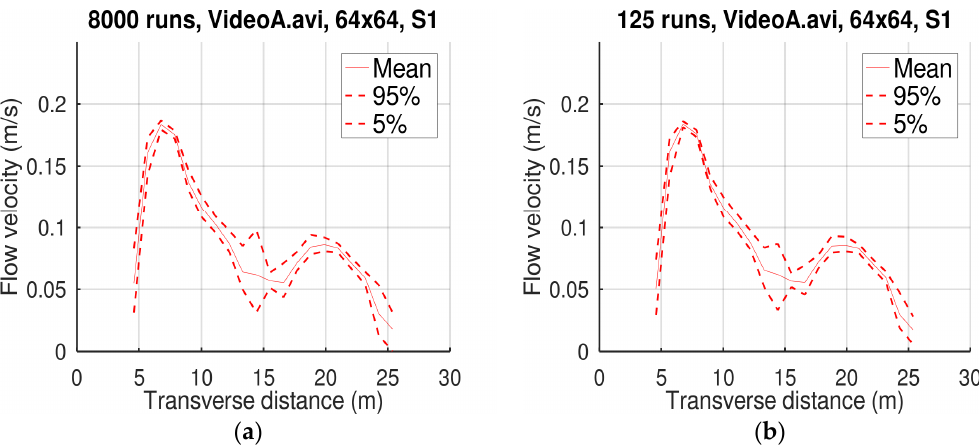
Figure 3. Mean velocity profile and confidence intervals of Monte Carlo simulations with 20 3 ( a ) and 5 3 ( b ) runs, and L = 32.